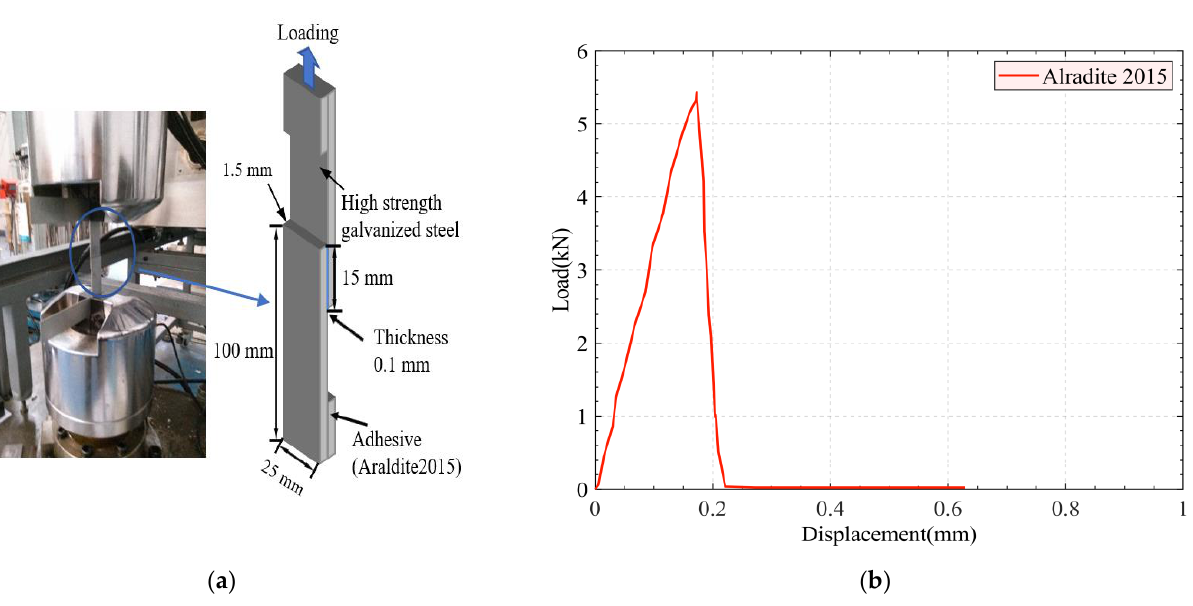
Figure 5. Single-lap shear test; ( a ) Experiment setup and sample dimension ( b ) Load – displacement curve in SLP test.